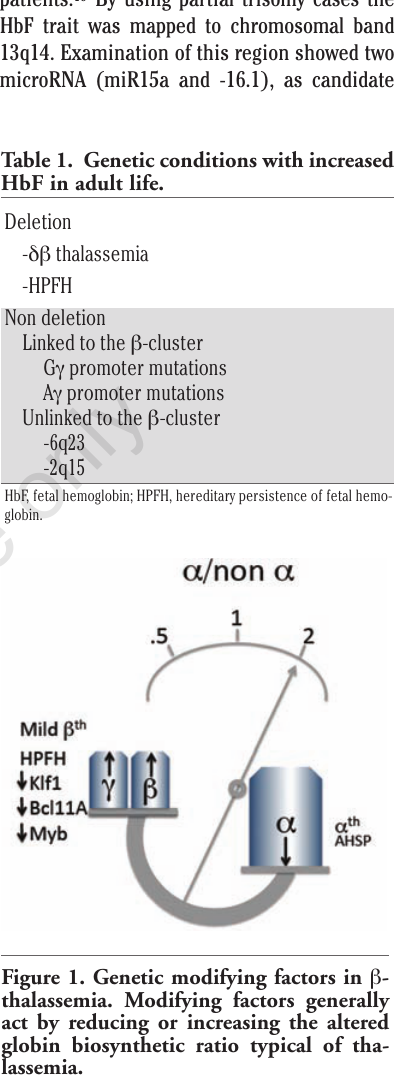
Figure 2. HbF associ- ated SNPs. Chromo - some bands, associ- ated genes and rela- tive SNP positions are indicated. Variance of the HbF (H2) in the Sardinian popula- tion is shown in parenthesis for the SNPs with the high- est association at each locus. SNP, Single nucleotide p o l y m o r p h y s m ; HBF, fetal hemoglo-